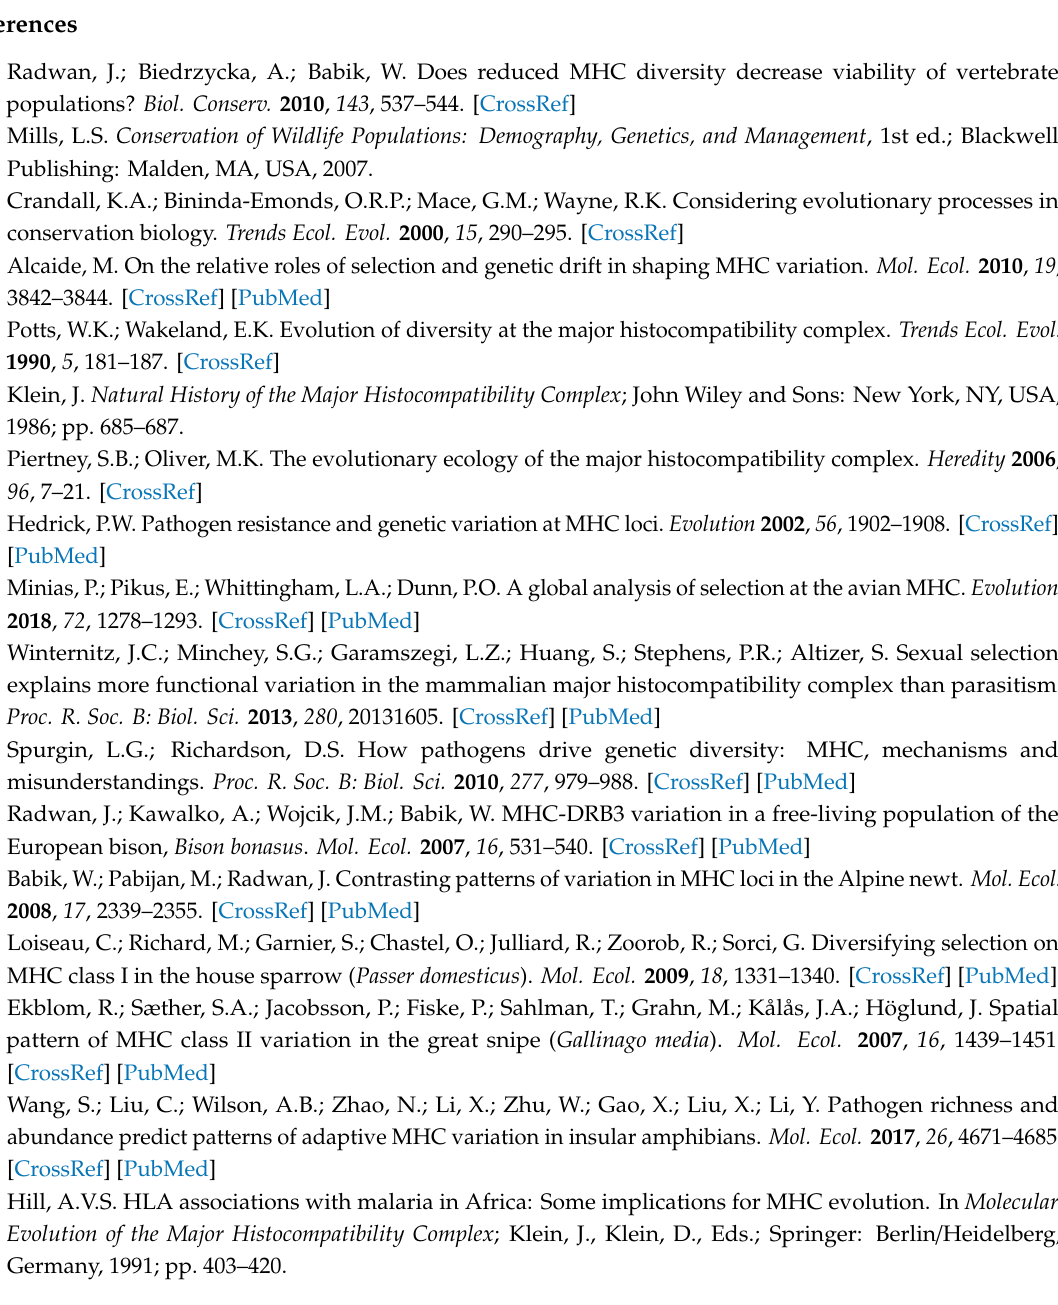
P7 for each haplotype. Table S5. Recombination events between the full-length sequences of Nini -II β genes, identified using RDP. Table S6. Allele frequencies (%) of microsatellite loci across seven populations of crested ibis. Table S7. Pairwise F ST values between populations for MHC (below diagonal) and microsatellites (above diagonal). Table S8. Results of the hierarchical AMOVA for the crested